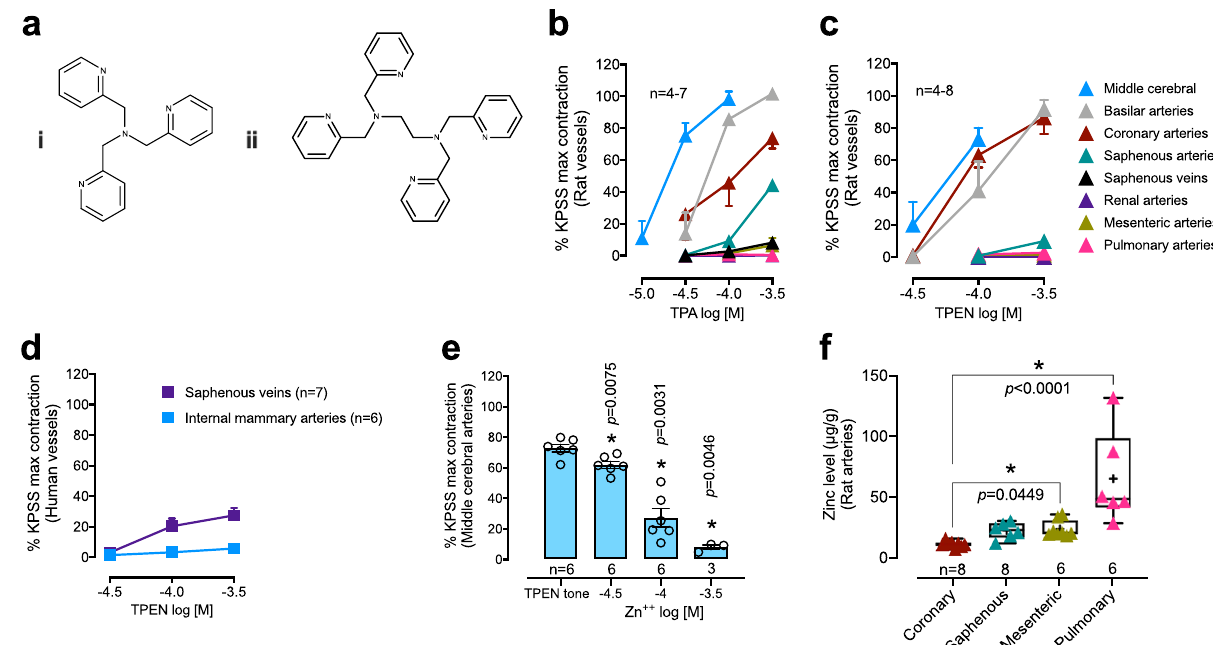
Fig. 2 Zinc chelators contract selected rat and human isolated arteries. a Chemical structures of the cell-permeable zinc chelators used: TPA ( i ) and TPEN ( ii ). b – d Selective contractile effects of the zinc-selective chelators, TPA ( b ) and TPEN ( c ) on resting (basal) tone in vessels from rats and humans ( d ). e Zinc added after contraction of middle cerebral arteries with TPEN (100 µ M) caused reversal of the effect. f Zinc levels per wet weight in rat arteries. Whiskers are min to max values and boxes are 25 – 75th percentile, where the line inside the box is the median and the + sign is the mean. Responses in b – e are %KPSS. Error bars are SEM (those not shown are contained within the symbol). n , number of arteries isolated from individual rats/humans. *Statistically signi fi cant, mixed-effects 1-way ANOVA [ F (1.55, 6.2) = 62.81, p = 0.0001] with Dunnett ’ s post-test compared to TPEN tone in e and Kruskal – Wallis test [ H (3) = 20.97, p = 0.0001] with Dunn ’ s post-test in ( f